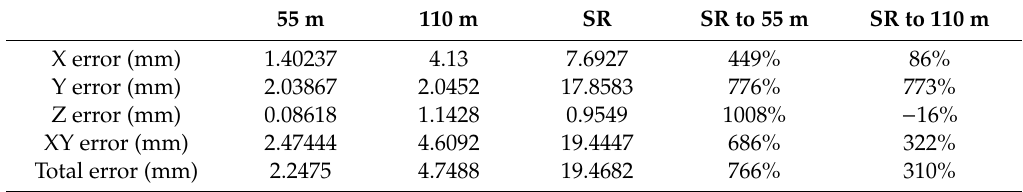
Table 5. GCP locations, error estimates, and percentage di ff erence calculations for the Phantom 4 Pro. 55 m 110 m SR SR to 55 m SR to 110 m X error